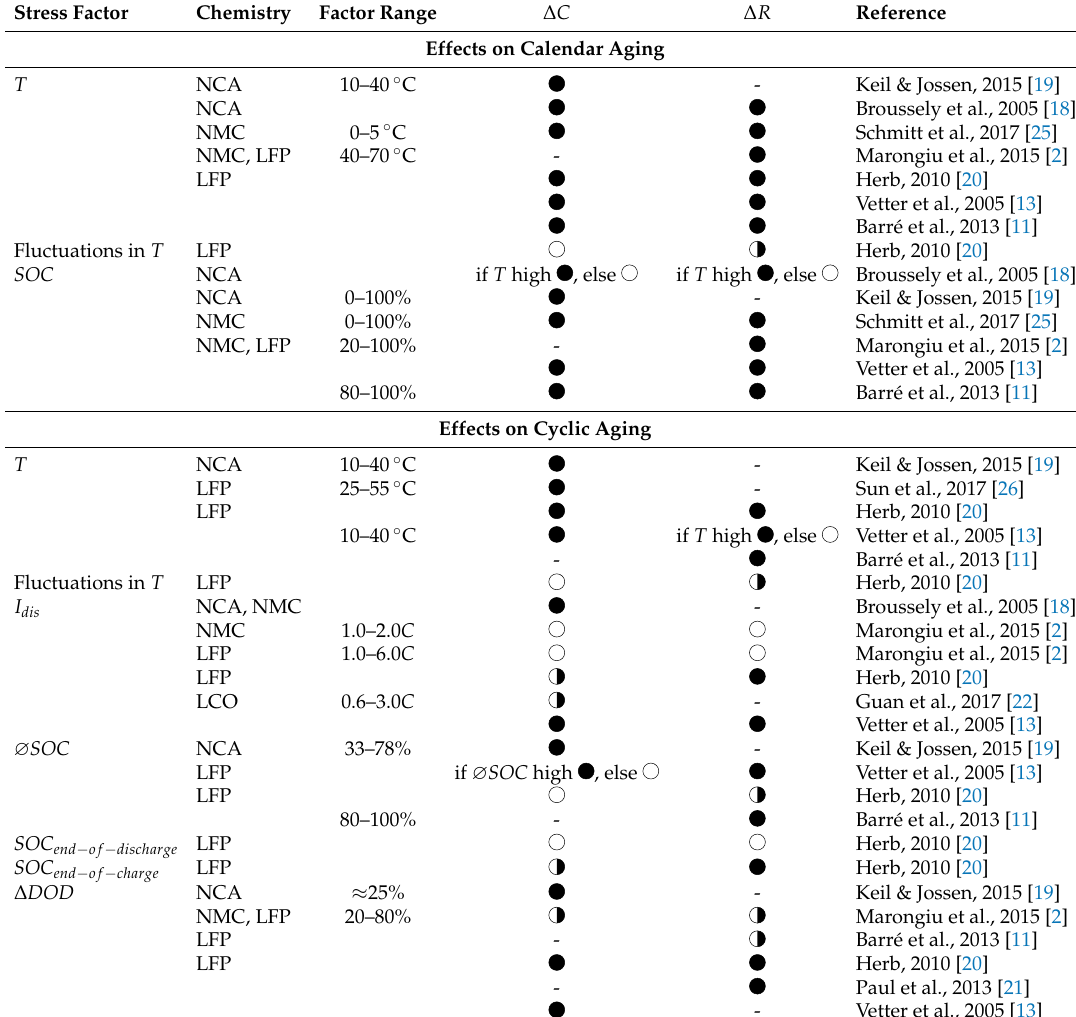
Table 1. Literature review on aging studies: The relevance of the stress factors on the aging effects ∆ C or ∆ R is qualitatively classified as having no influence , minor influence , or strong influence . Additional information on the investigated cell chemistry and the value range of the stress factors is provided. This overview reveals a controversy on the relevance of stress factors for cyclic